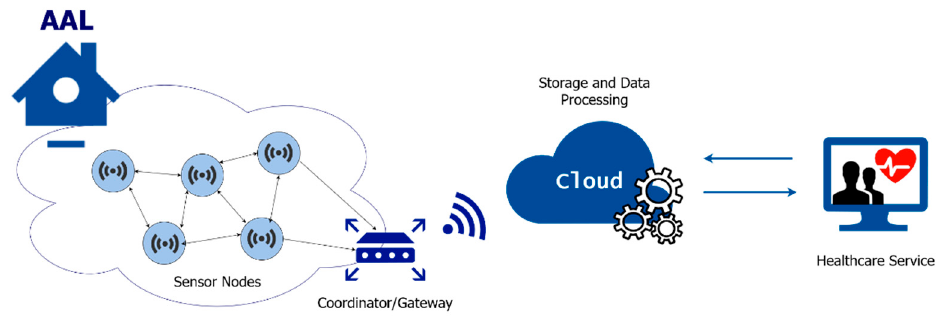
Figure 1. General architecture of a healthcare Internet of Things (IoT) system.